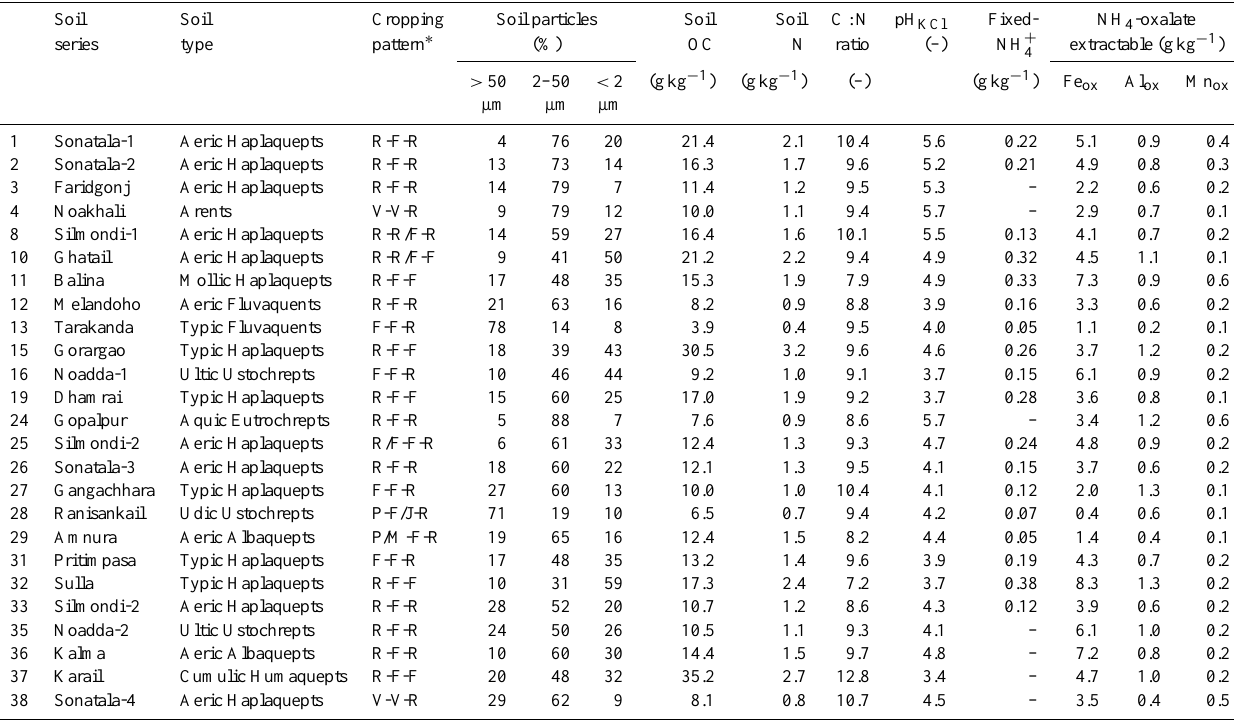
Table 1. Soil properties of sampled agricultural fields in Bangladesh (data from Kader et al., 2013).